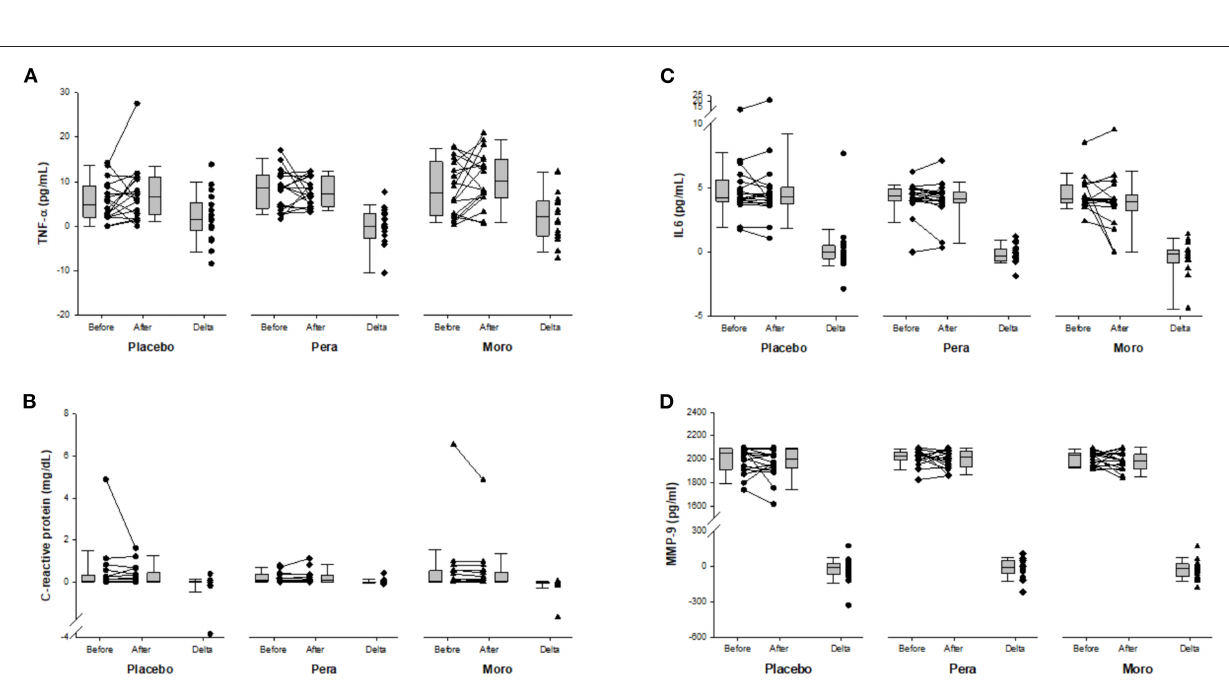
Frontiers in Nutrition | www.frontiersin.org